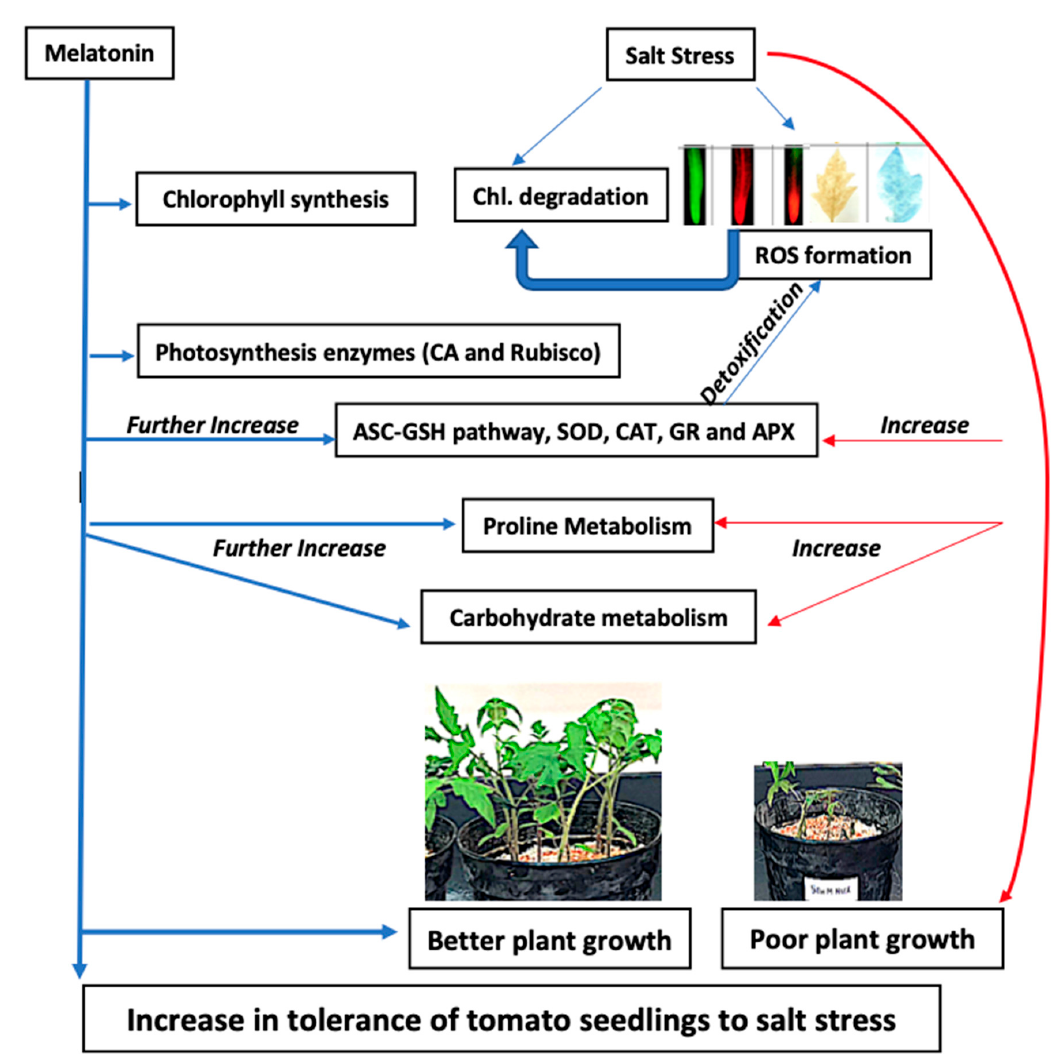
Figure 11. Summary of melatonin ‐ induced tolerance against salinity by regulating the antioxidant system, proline and carbohydrate metabolism and photosynthetic pigments synthesis in plants. Ch ‐ chlorophyll, ROS ‐ reactive oxygen species, CA ‐ carbonic anhydrase, ASC ‐ ascorbate, GSH ‐ reduced glutathione, SOD ‐ superoxide dismutase, CAT ‐ catalase, GR ‐ glutathione reductase, APX ‐ ascorbate peroxidase.